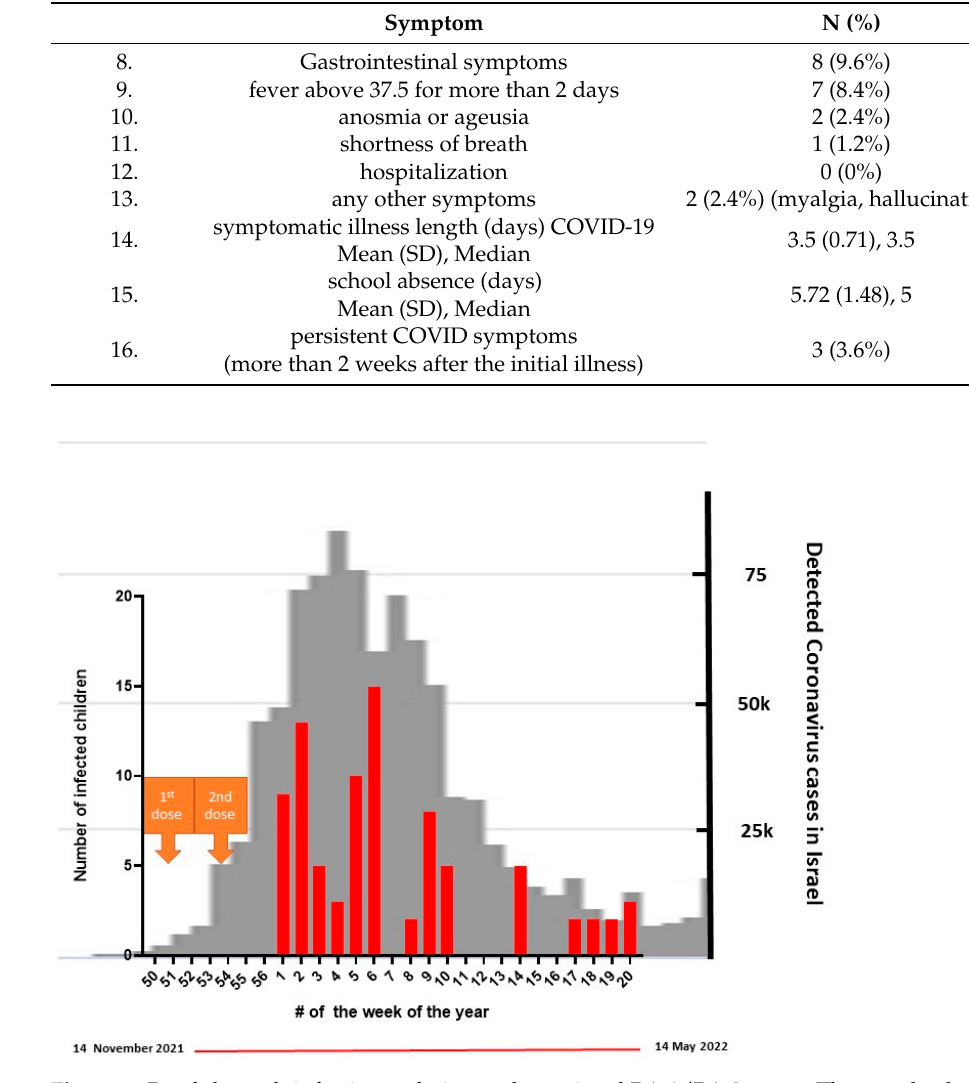
Figure 2. Breakthrough infections relative to the national BA.1/BA.2 wave. The grey background describes the BA.1/BA.2 national wave. The red bars represent the number of children infected in our cohort during the Omicron wave.